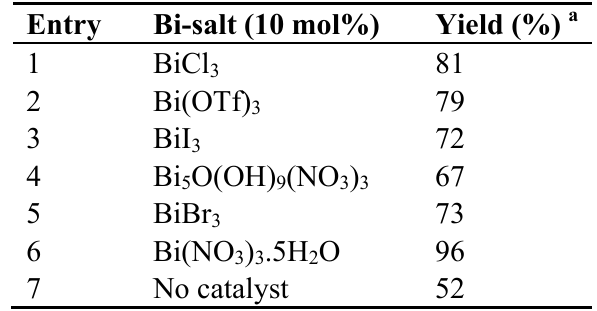
Table 1. Microwave-assisted one-pot, three component synthesis of 1,4-dihydropyridines from benzaldehyde (1 mmol), ethyl acetoacetate (2 mmol) and ammonium acetate (1 mmol) using bismuth-salts as catalyst (10 mol%) under solventless condition (1 min): catalyst